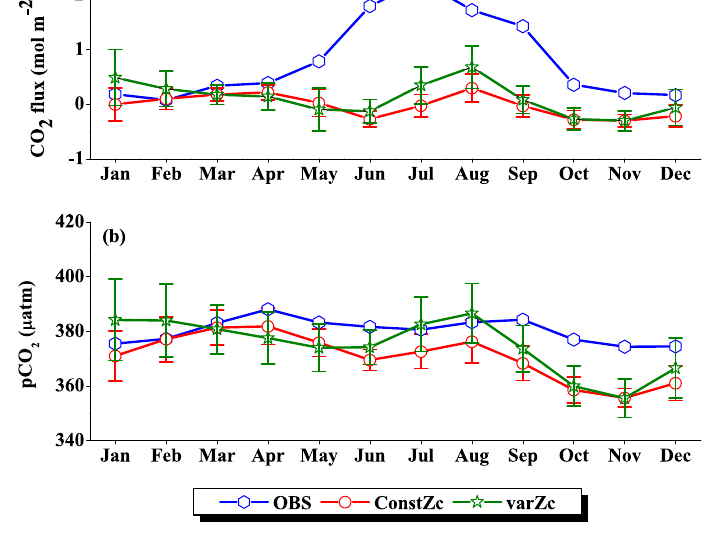
Figure 10. Same as Fig. (6), but for SLD.